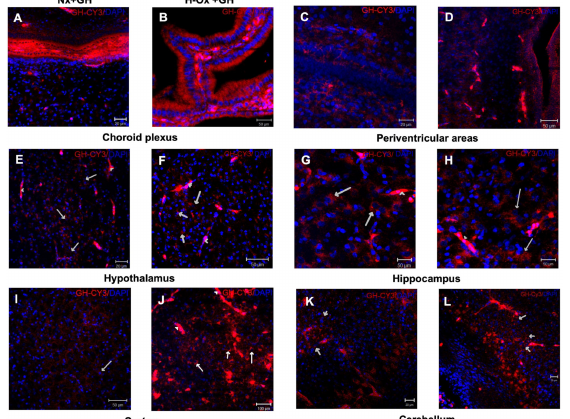
Figure 2. Distribution of Cy3-GH signal in several brain areas in the chicken embryo. Representative images showing the presence of Cy3-GH in the choroid plexus ( A , B ), periventricular areas ( C , D ), hypothalamus ( E , F ), hippocampus ( G , H ), cortex ( I , J ), and cerebellum ( K , L ) 2 h after its administration through the chorio-allantoid vein. The images correspond to animals that were maintained in normoxia ( A , C , E , G , I , K ) and animals exposed to hypoxia ( B , D , F , H , J , L ). The arrows indicate the presence of Cy3-GH in cells, while the arrowheads indicate vessels where the fluorescent hormone was found. Scale bar 20 µ m in ( C , E , K , L ); 50 µ m in ( A , B , D , F , G , H , I ) and 100 µ m in ( J ).